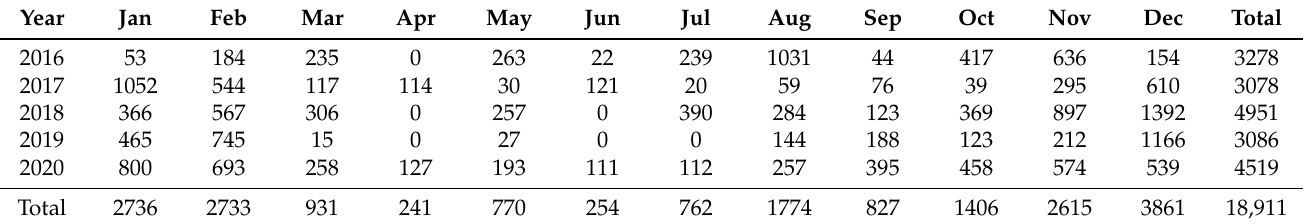
Table 2. Sample crash (filtered by injury-only) data involving adverse conditions. In this case, a combination of foggy (and similar) weather with darkness and possible ambient